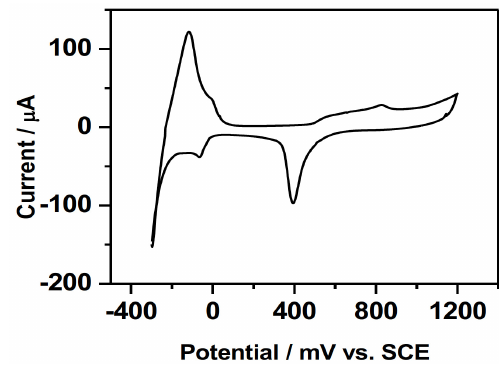
Figure 2. Cyclic voltammogram of palladium on gold electrode in sulphuric acid medium.